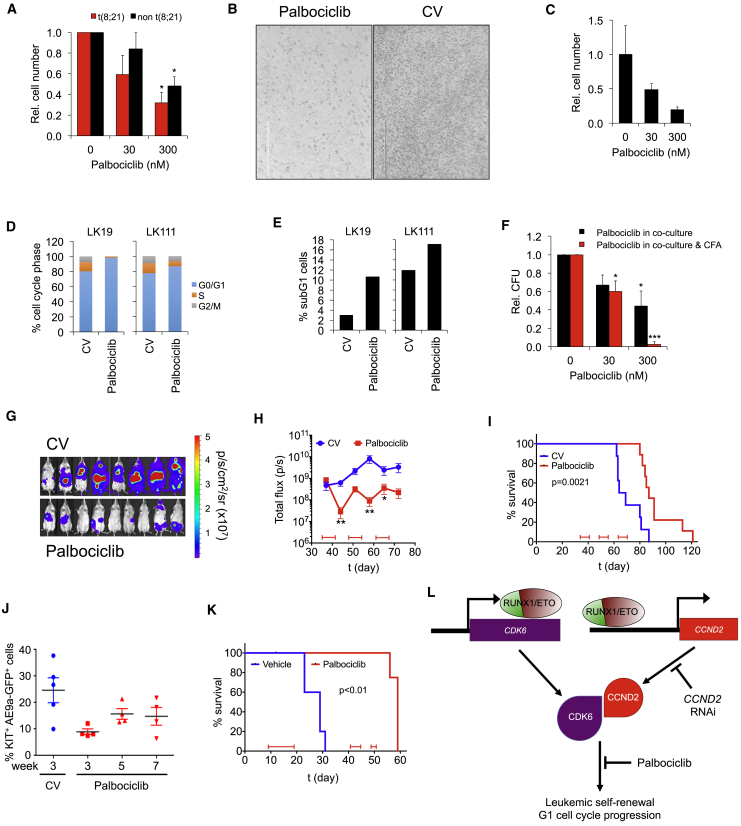
CDK4/6 Inhibition Impairs Proliferation of Primary AML Cells and Increases Median Survival In Vivo(A) Impact of palbociclib on proliferation of primary AML blasts. Blasts were co-cultured on MSC feeder layers with and without 300 nM palbociclib for 72 hr. Mean ± SD; n = 3 for both t(8;21) and non-t(8;21) AML patient samples. ∗p < 0.05 compared with no palbociclib.(B) Phase contrast photographs showing primary t(8;21) AML blasts from patient sample LK111 in co-culture with MSCs with and without (CV) palbociclib. Standard bar, 200 μm.(C) Proliferation of a t(8;21) AML sample from a relapsed patient on MS-5 feeders upon palbociclib treatment for 72 hr. Mean ± SD; n = 3 technical replicates.(D and E) Cell cycle distribution (D) and changes in apoptotic subG1 cell fractions (E) of primary AML blasts obtained from two t(8;21) patients (patient samples LK19 and LK111) on MSC after 96 hr incubation with and without (CV) palbociclib.(F) Clonogenic growth of three different t(8;21) patient samples after MSC co-culture for 96 hr. Indicated palbociclib concentrations were added either only to co-culture medium (Palbociclib in co-culture) or to both co-culture and semisolid medium (Palbociclib in co-culture & CFA). Colony numbers are relative to no palbociclib. Mean ± SD; n = 3. ∗∗∗p < 0.001; ∗p < 0.05 compared with no palbociclib.(G) Bioluminescent images of RG mice transplanted with luciferase-expressing (luc+) Kasumi-1 cells after 21 days of treatment with control vehicle (CV) or palbociclib.(H) Luminal flux of bioluminescence for CV (n = 8) or palbociclib-treated animals (n = 9). Treatment blocks are indicated at the bottom of the graph. ∗∗p < 0.01; ∗p < 0.05 compared with no palbociclib by one-way ANOVA using a D'Agostino and Pearson test; mean ± SEM.(I) Survival curve for RG mice transplanted with luc+ Kasumi-1 cells. Significance was tested by log rank test.(J) Percentage of Kit+ RUNX1/ETO9a (AE9a) GFP+ cells in mice after CV or palbociclib treatment as determined by fluorescence-activated cell sorting (FACS).(K) Survival curve for Bl6 mice transplanted with KIT+ AE9a GFP+ cells. Significance was tested by log rank test. n = 5 for both groups with one censored animal in the palbociclib group due to death unrelated to palbociclib treatment.(L) Model depicting the RUNX1/ETO-promoted G1 cell cycle progression and leukemic propagation by direct transcriptional activation of CCND2 and CDK6, which can be blocked by either CCND2 knockdown or by pharmacologic inhibition of CDK4/6-CCND complexes.See also Figure S7.